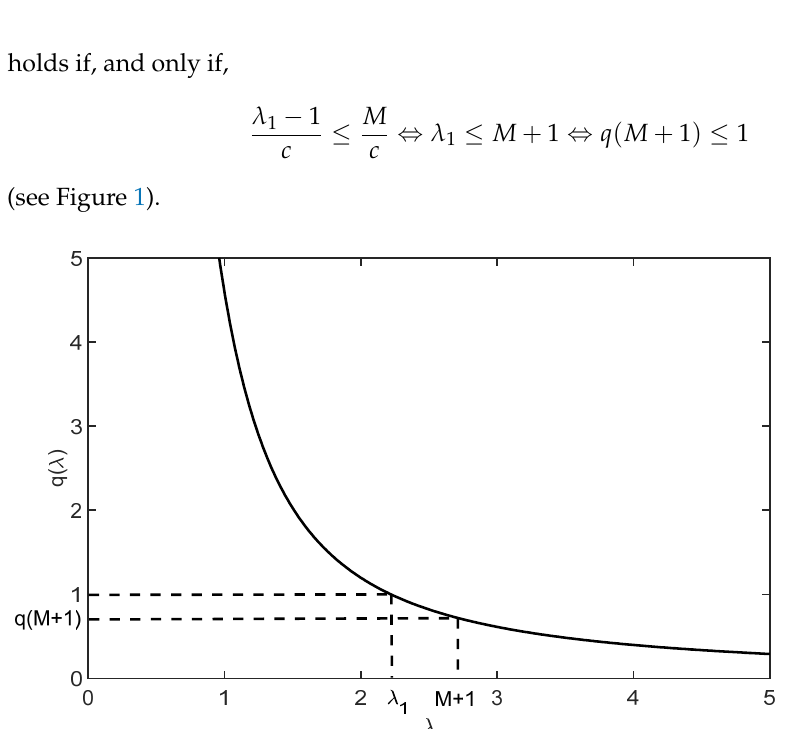
q ( λ ) = ∞ , lim q ( λ ) = 0 and λ 1 ≤ M + 1 ⇔ λ → + 0 λ → ∞